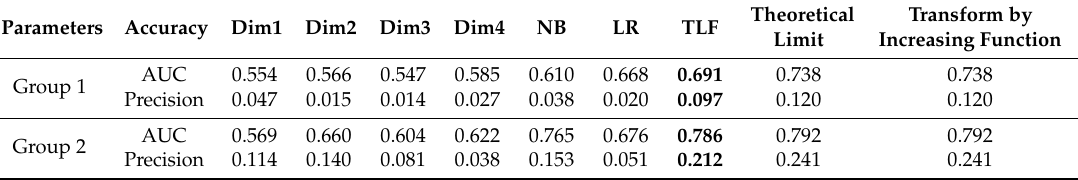
Table 2. Simulation results of group 1 and group 2. The bold figure indicates the best accuracy in each dimension and combination method.